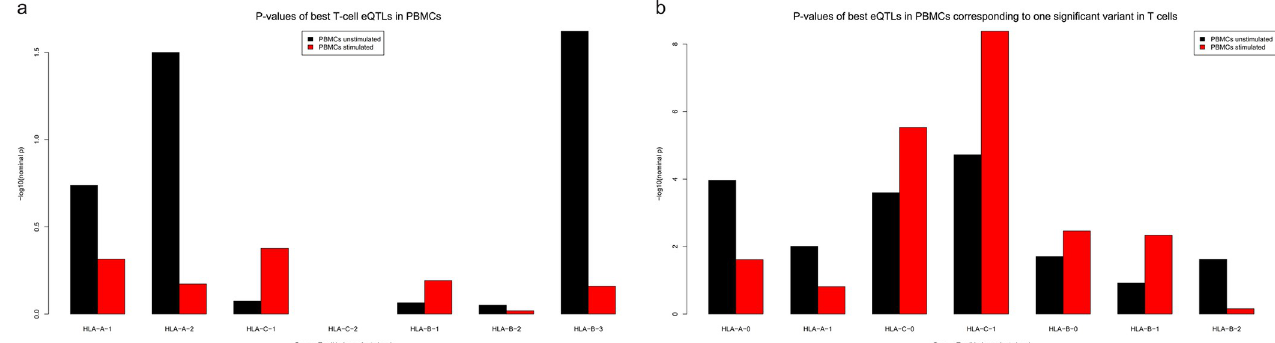
Fig 6. Comparison of best SNPs between T cells, unstimulated PBMCs and stimulated PBMCs. ( a ) The -log10 nominal p-values of the best variant for a T- cell independent signal in PBMCs. ( b ) The -log10 nominal p-values of the best PBMC variant amongst all the significant variants for each of T-cell independent